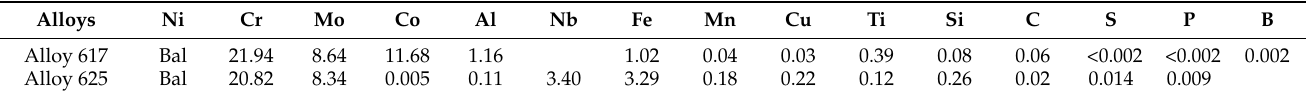
Table 1. Chemical compositions of the two nickel-based alloys in wt%.